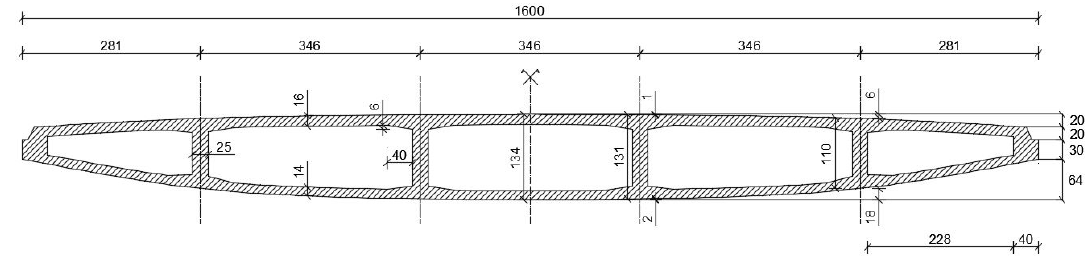
Figure 4. RC box deck cross-section of the Musmeci bridge.